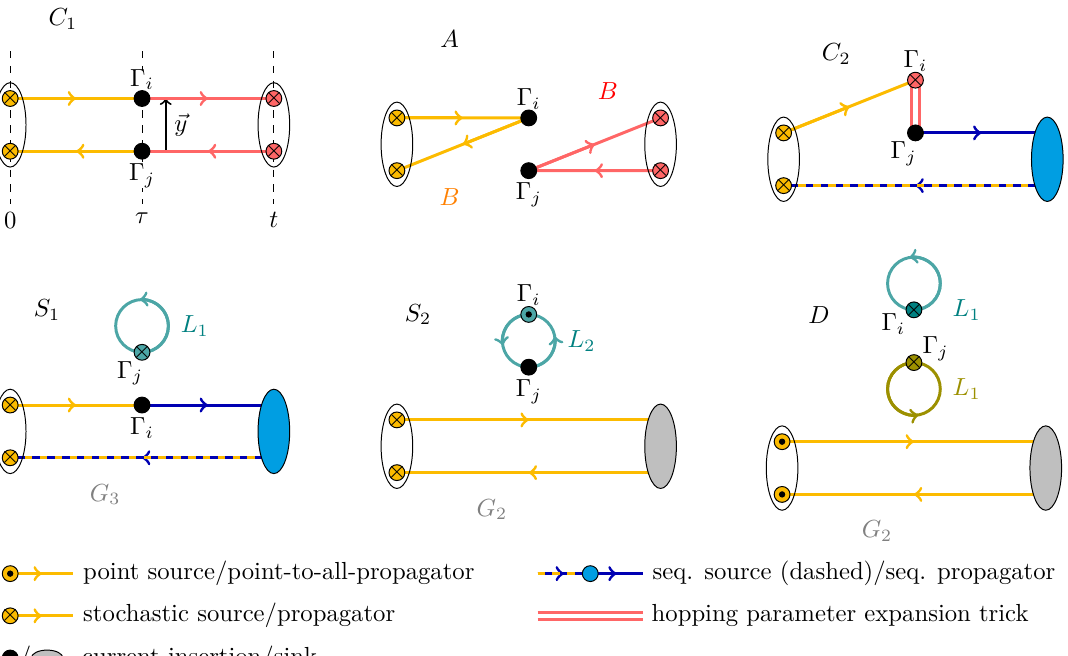
Figure 3. Lattice methods employed for computing the di(cid:11)erent graphs of the four-point function. Colours are used to distinguish the di(cid:11)erent parts of a graph. Two stochastic sources within a pion source or sink lead always to the application of the one-end trick or two-hand-trick,